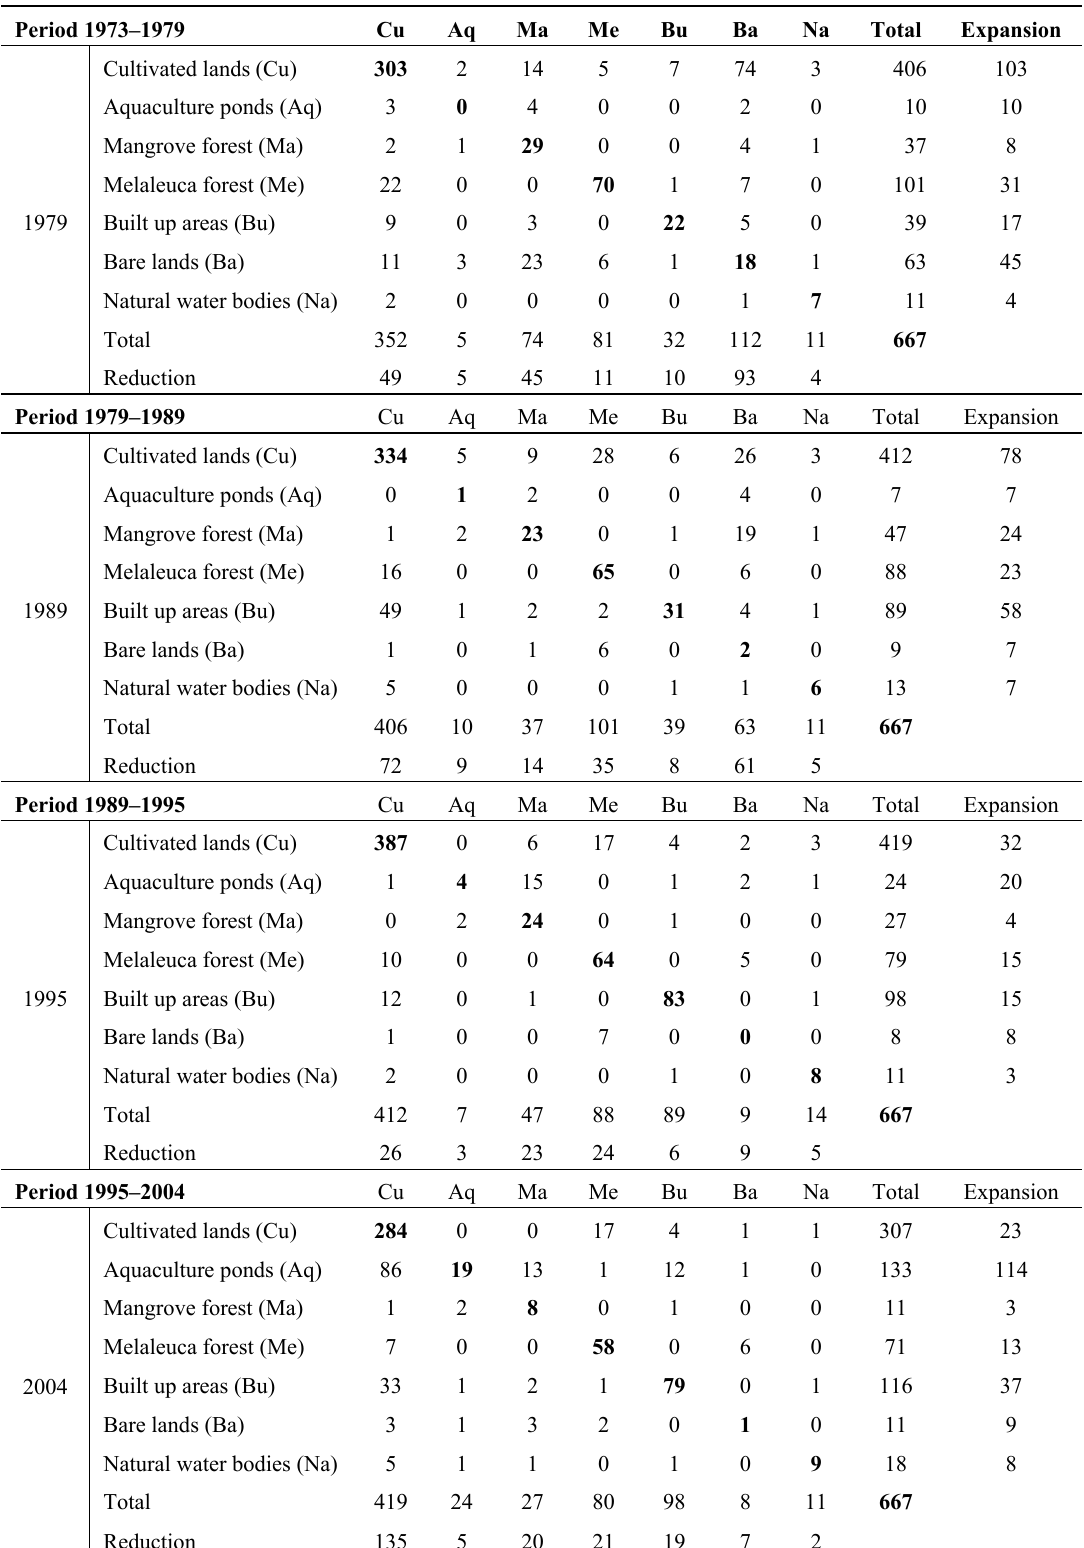
Table 3. Nature of the land cover/land use changes in the Tran Van Thoi District from 1973 to 2011 in km 2 (figures are rounded up to entire numbers). (Cloud and shadow class is constant in all tables, 32 km 2 ). ( The values on the diagonal represent the amount of each land cover/land use class that did not change, while the remaining values refer to the expansion or reduction of the classes )